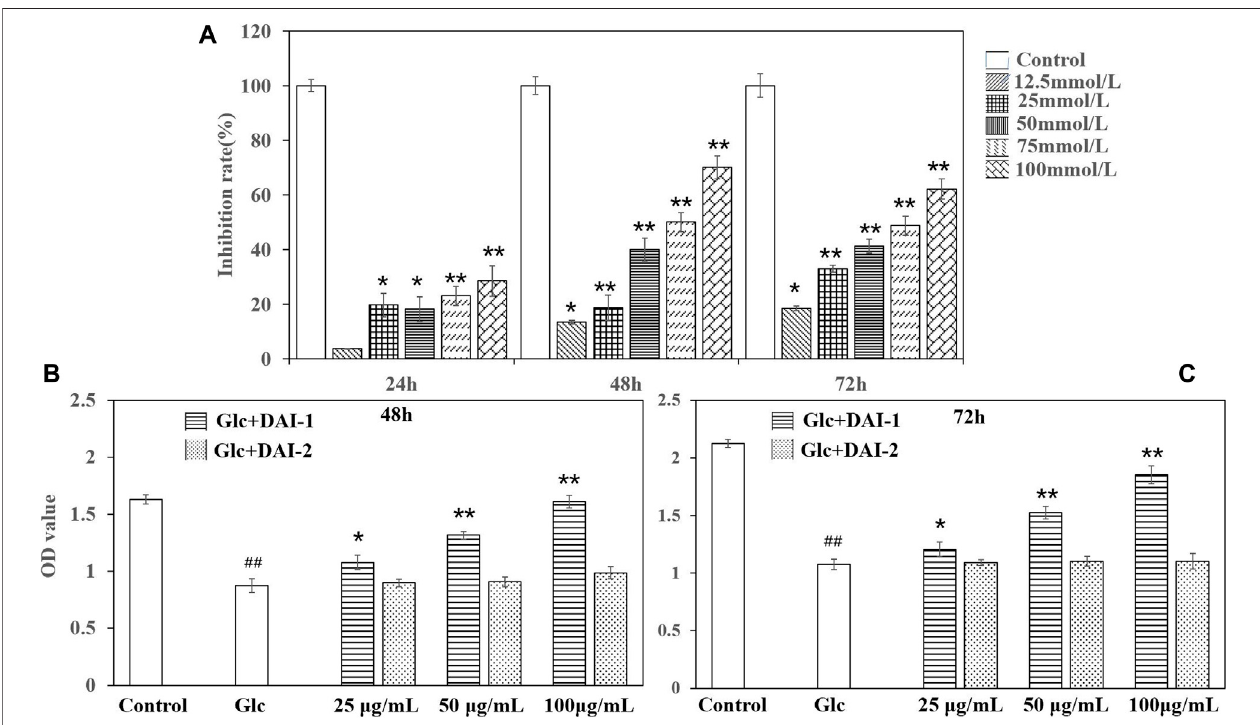
FIGURE 3 | The effects of different glucoseconcentrations on osteoblast growth rates (A) . *: p < 0.05, **: p < 0.01, for high-glucose group (represented by ‘ Glc ’ in the fi gure) vs .thecontrolgroup(representedby ‘ Control ’ inthe fi gure).TheeffectsofexposingosteoblaststoDAI-1andDAI-2underahigh-glucoseenvironmentfor48 h (B) and 72 h (C) . ## : p < 0.01, for high-glucose group vs . the control group; *: p < 0.05, **: p < 0.01, for the DAI-1and DAI-2 treated group vs . high-glucose group.